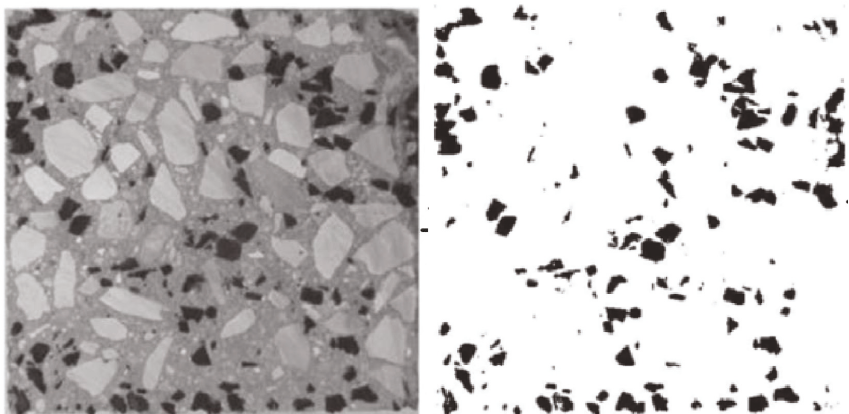
Figure 4: Aggregate and rubber distribution in the test [30].